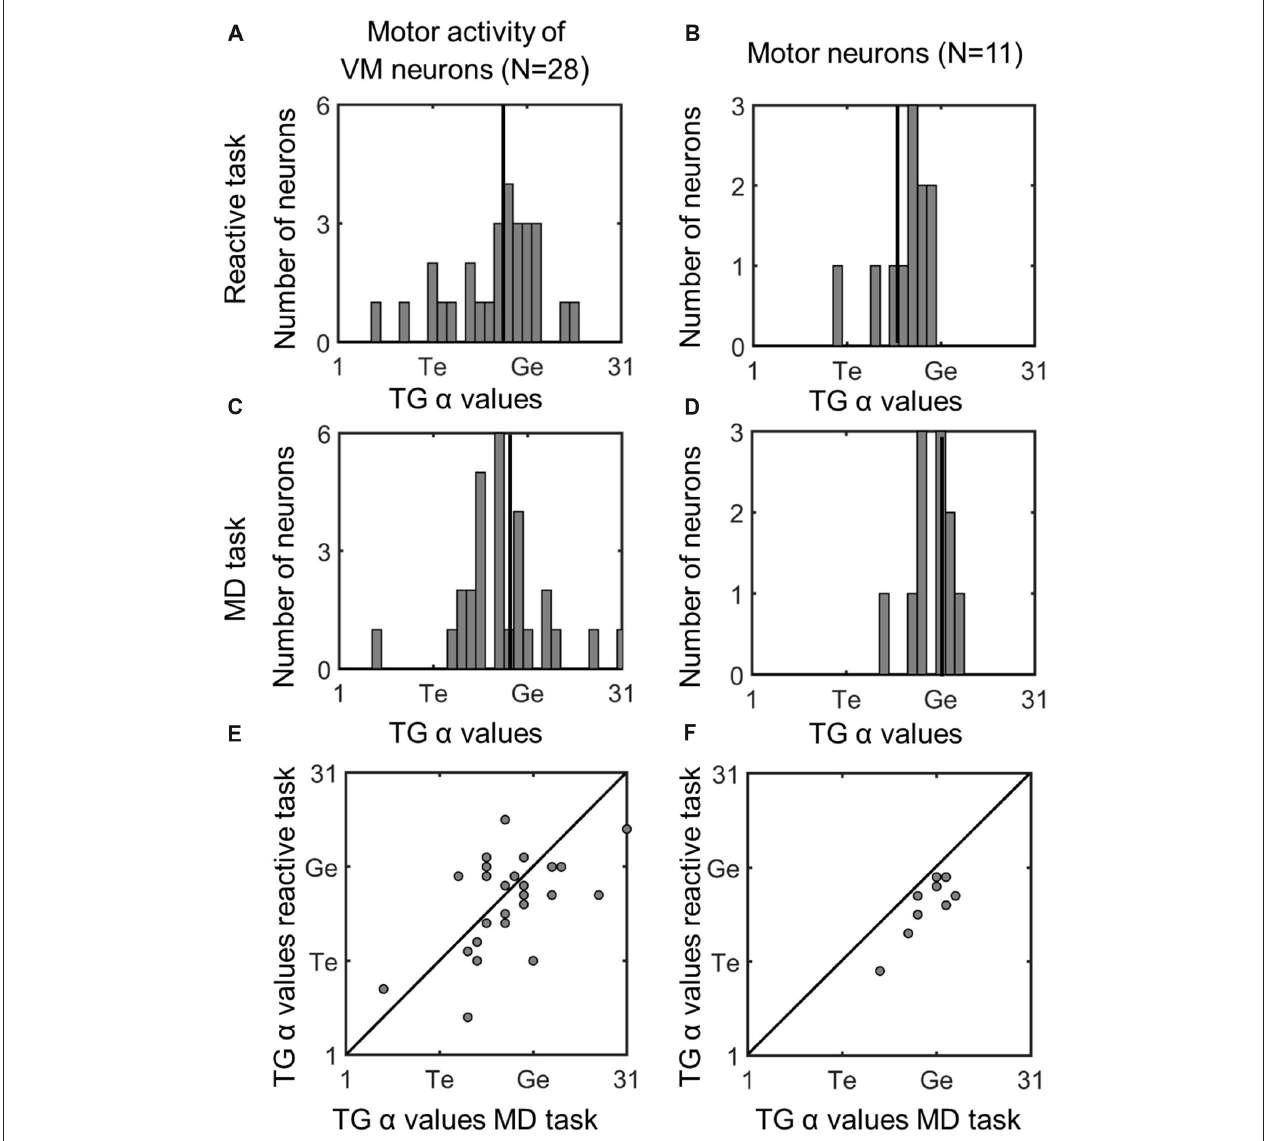
FIGURE 8 | Comparison of TG continuum coding of reactive vs. memory delay task in motor responses. Left column (A,C,E) : motor response of VM neurons; right column (B,D,F) : motor response of motor neurons. Otherwise, the conventions are the same as Figure 5 . There was a significant difference between the TG values in the two tasks in Motor Neurons, i.e., the fits were below the diagonal line in part (F) meaning motor neurons were more gaze-related in the MD